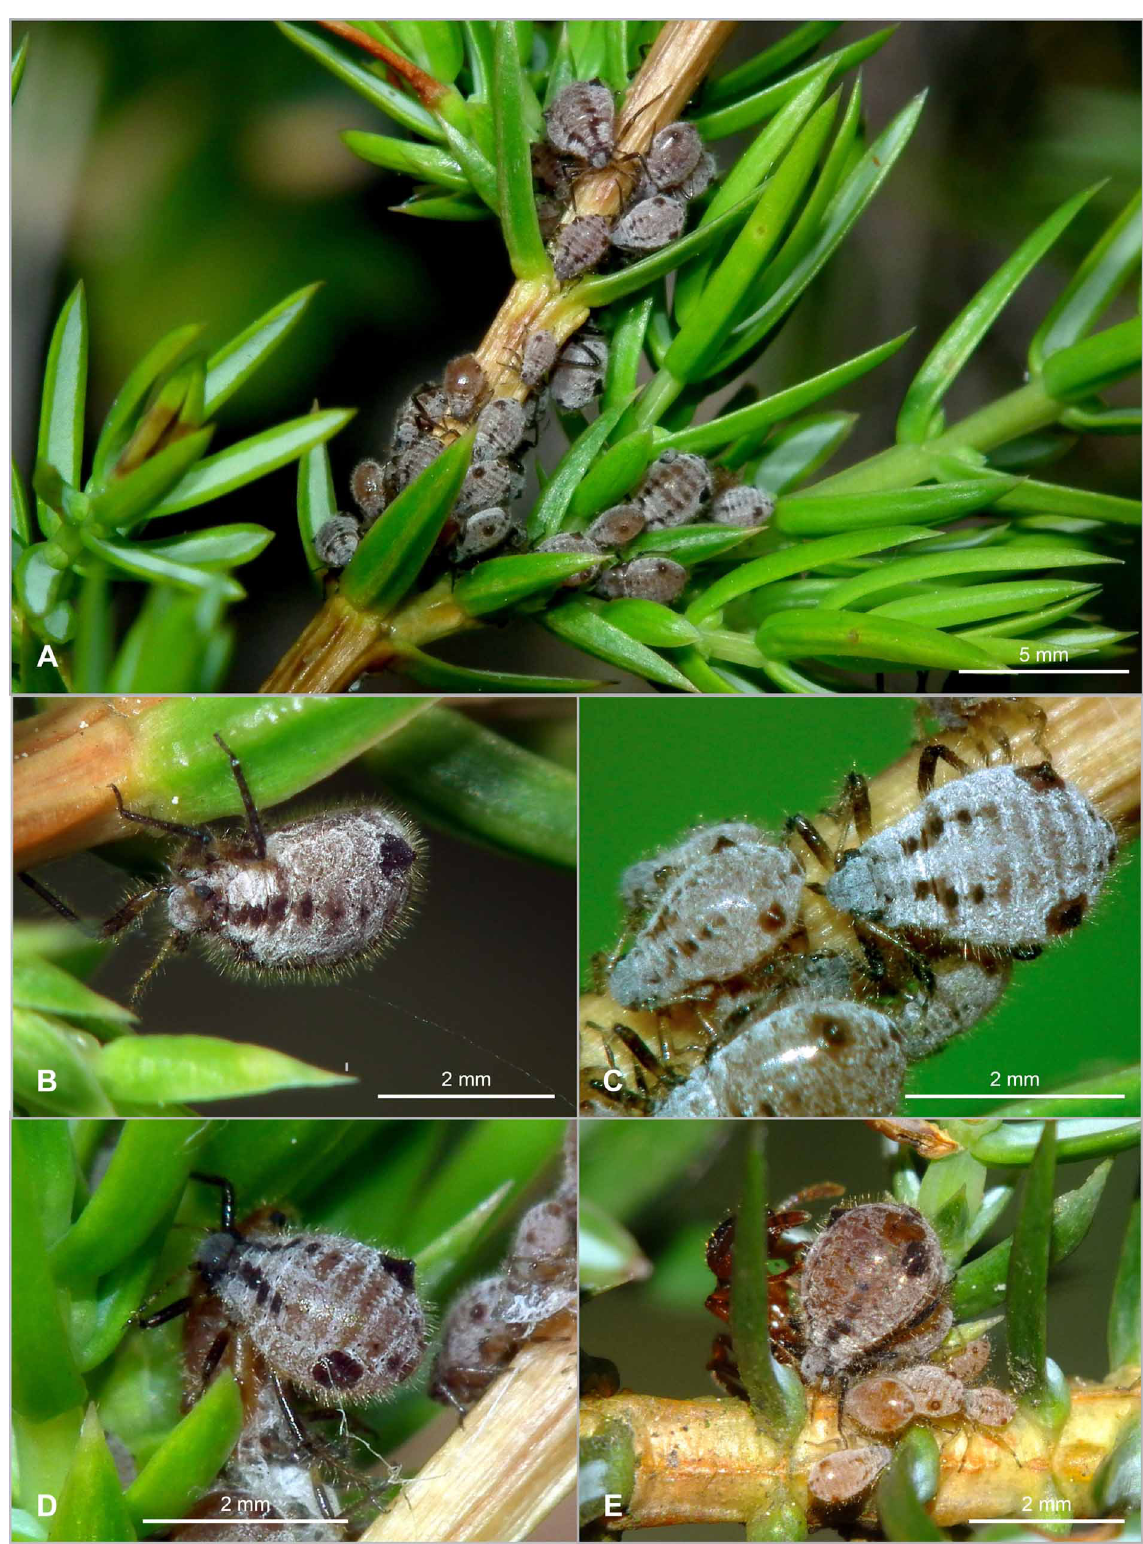
Fig. 115. Cinara (Cupressobium) juniperi (De Geer, 1773). Colonies on current and previous year’s twigs of Juniperus communis , in F attended by Myrmica rubra (Linnaeus,